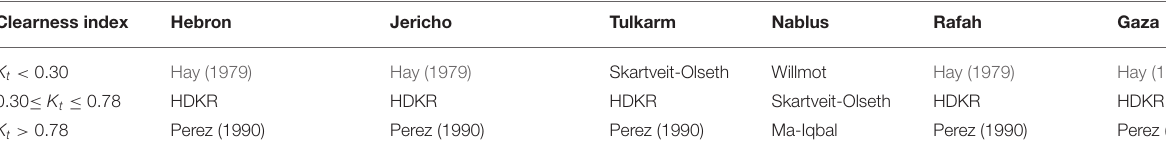
TABLE 5 | The best transposition models For different Kt. Clearness index Hebron K t < 0.30